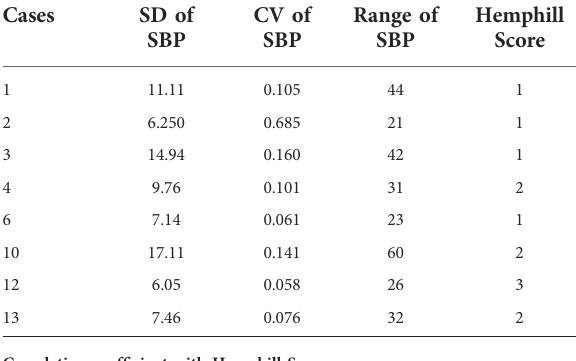
TABLE 4 Results of statistical analysis involving postoperative ICH patients.